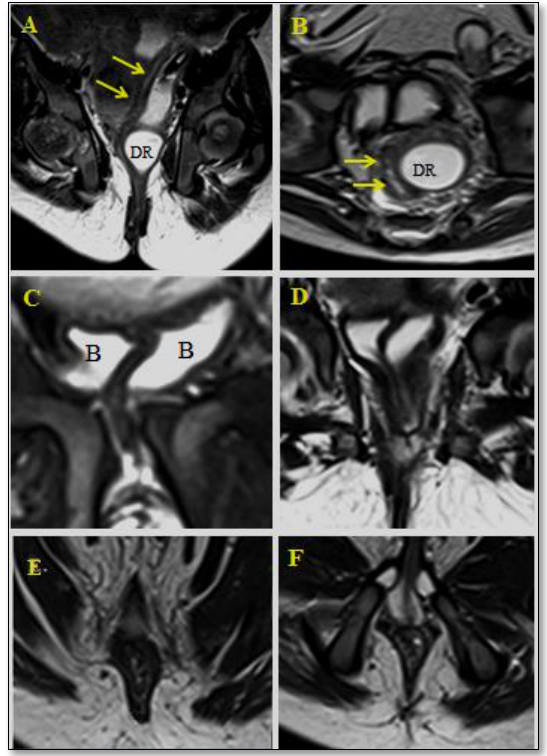
Figure 1: Anorectal duplication in a 6 months old male child. A & B: T2W coronal (A) and axial (B) images shows thin collapsed rectum ( ↘↘ ) on the right side of a distended tubular blind ending duplicated anorectal segment (‘DR’). C & D: T2W coronal (C) and axial (D) image shows complete duplicated bladder (B) with separate muscular coats. The septa extend into the posterior urethra. E: T2W axial image just below I plane shows well developed continuous EAS Figure 3: Intermediate ARM with vestibular fistula in a 6 muscle complex. F: T2W axial image below PC plane shows month old female child. A: Sagittal T2W images show the well formed puborectalis muscles encircling the rectum. relationship between the rectal pouch (R) and Bladder (B). Table 3: Anomalies in different Organ System Anomalies in the lower part (not